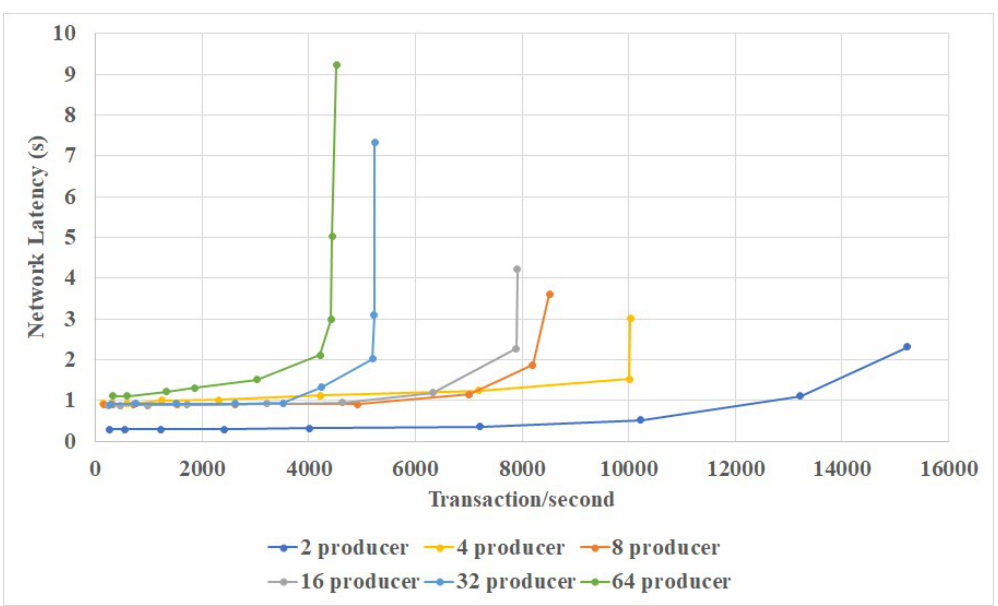
Figure 5. Relationship of network latency and transaction